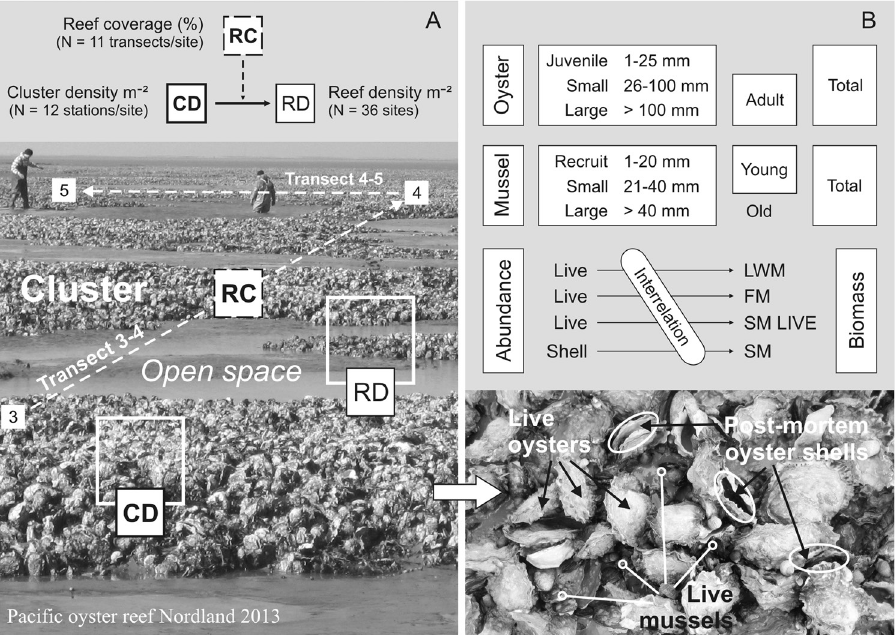
Figure 3. Density conceptual framework. A Areal reference. Cluster density (CD) reduced by reef cover- age (RC) results in reef density (RD). Depicted are three stations (3/4/5 à 0.0625 m²), two station con- necting transects (3-4/4-5) for RC and 1 m² encompassing CD/RD. B Density attributes. Abundance was calculated for SL-related population categories of live oysters, oyster shell and live mussels. Areal bio- mass was calculated from total abundance, respectively. Depicted are oysters and mussels in a cluster (top view). FM = cooked flesh mass, live = abundance of live oysters or mussels, LWM = live wet mass, shell = abundance of live oysters and post-mortem oyster shells, SM = shell mass of live oysters and post-mortem oyster shells, SM LIVE = shell mass of live oysters or mussels. See text for